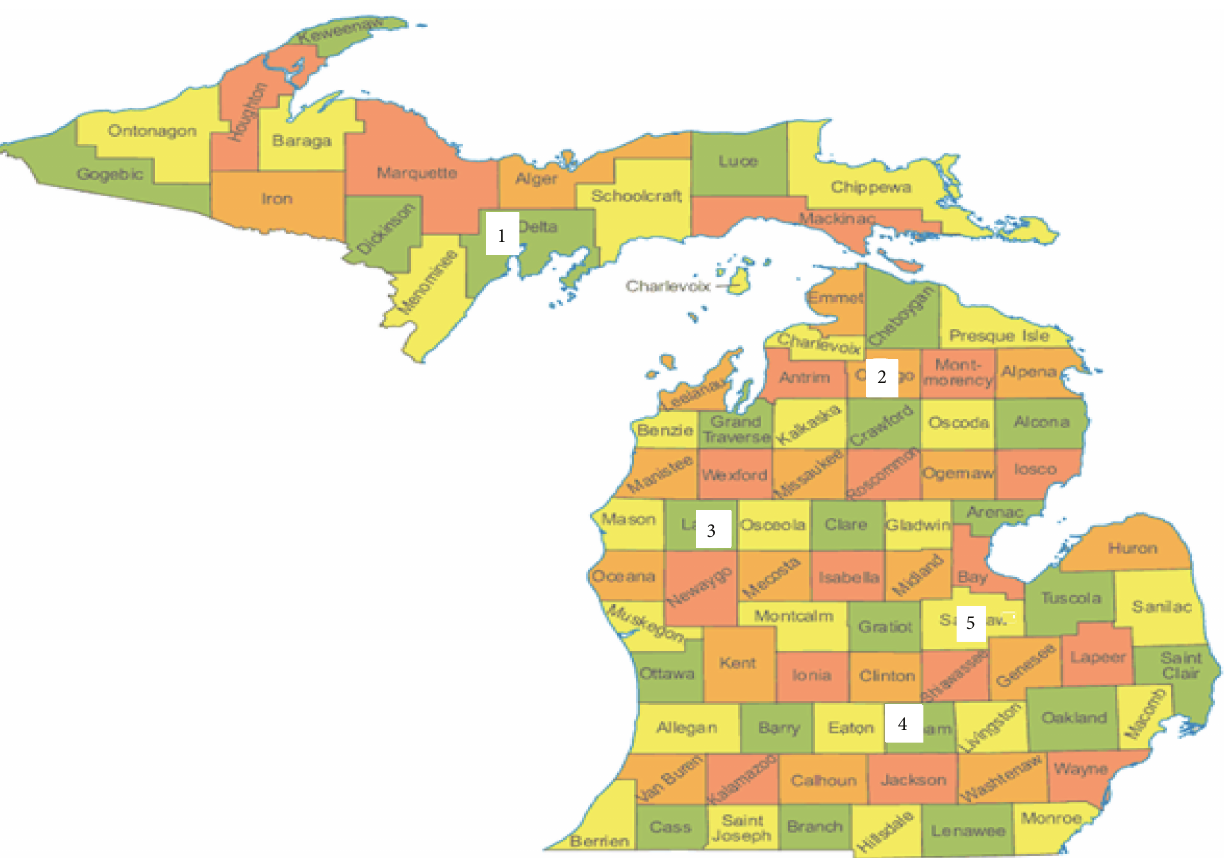
Figure 2: The geographic locations for the hospital network in Michigan in the United States, problem set